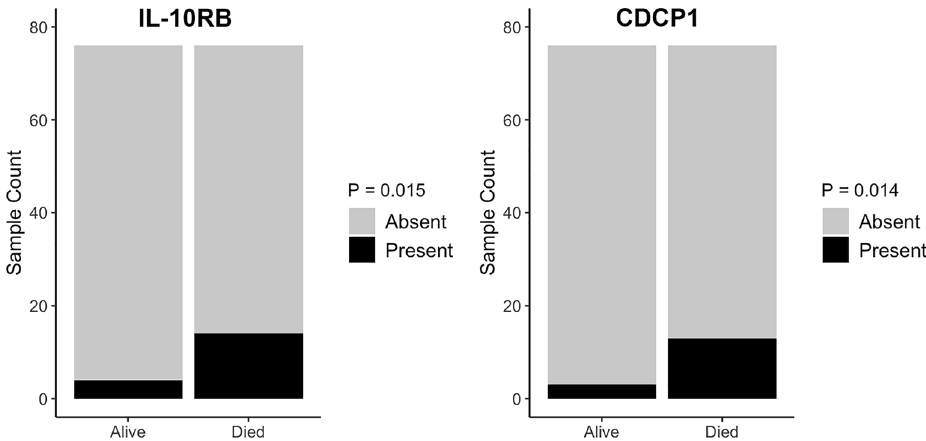
Figure 4. The presence of EV IL-10RB and CDCP1 and mortality. Plasma EVs were isolated from 76 individuals deceased within 5 years along with 76 surviving individuals and lysed EVs were analyzed using a proximity extension assay. Presence of each inflammatory protein with mortality status was analyzed using logistic regression accounting for sex, race and poverty